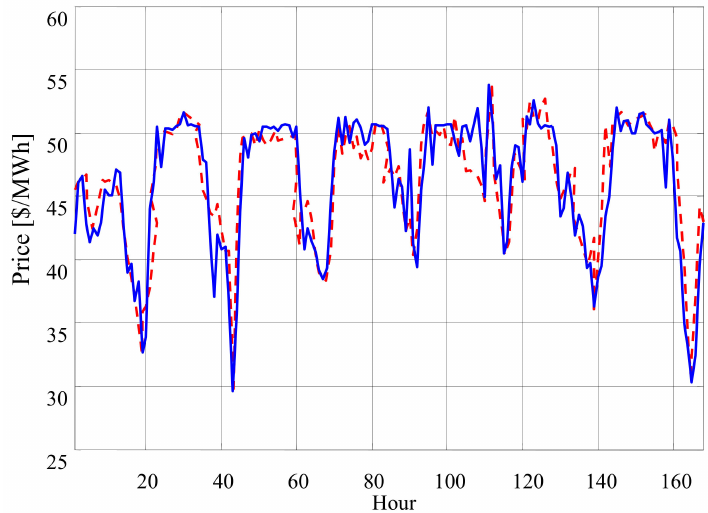
Figure 13. The weekly price forecast for Australia’s electricity market for the first two months of 2010; the continuous blue line (the real price) and the dotted red line (the forecast value).